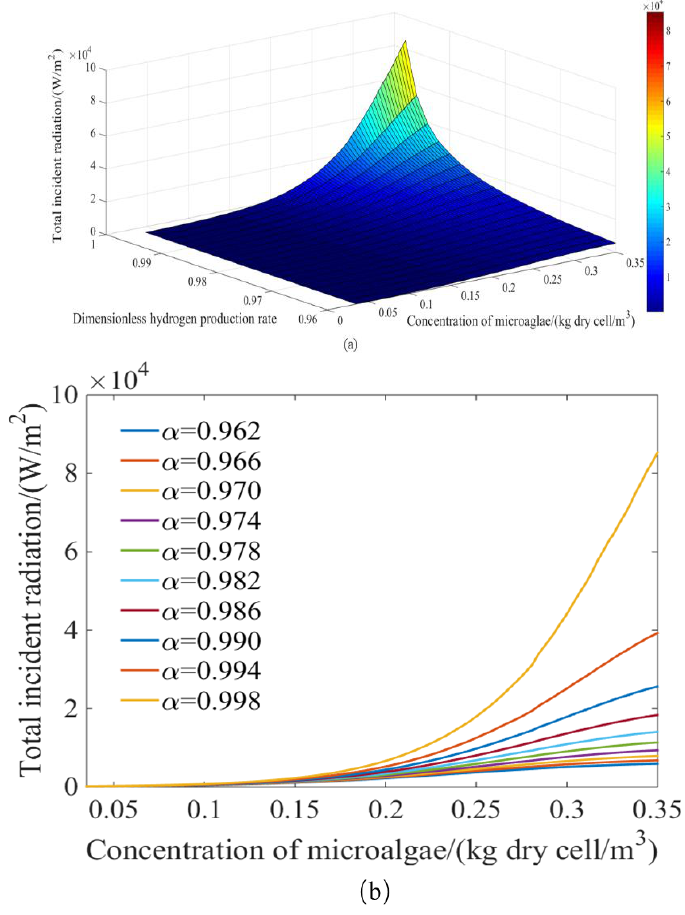
Figure 9. ( a )The performance surface of total incident radiation varying with the dimensionless hydrogen production rate (0.96–0.998) and the microalgae concentration; ( b ) the family of curve converted from Figure 9a.